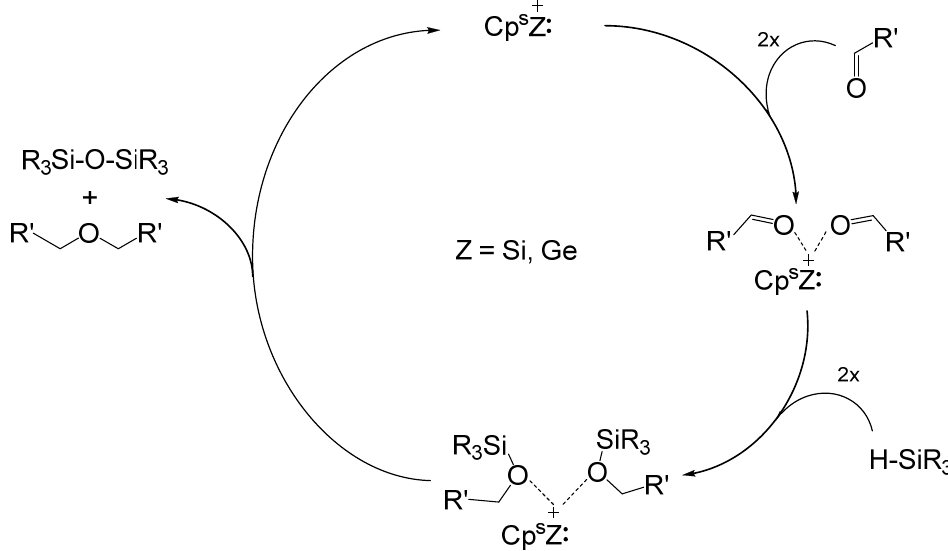
Scheme 14. Catalytic cycle of the oxidative coupling reaction of R 3 Si-H using aldehydes R’CHO in the presence of cationic Cp-coordinated Si(II) and Ge(II) compounds 1 and 2 , with Cp s = substituted Cp residue, such as Me 5 Cp or (SiMe 3 ) 3 Cp [30].